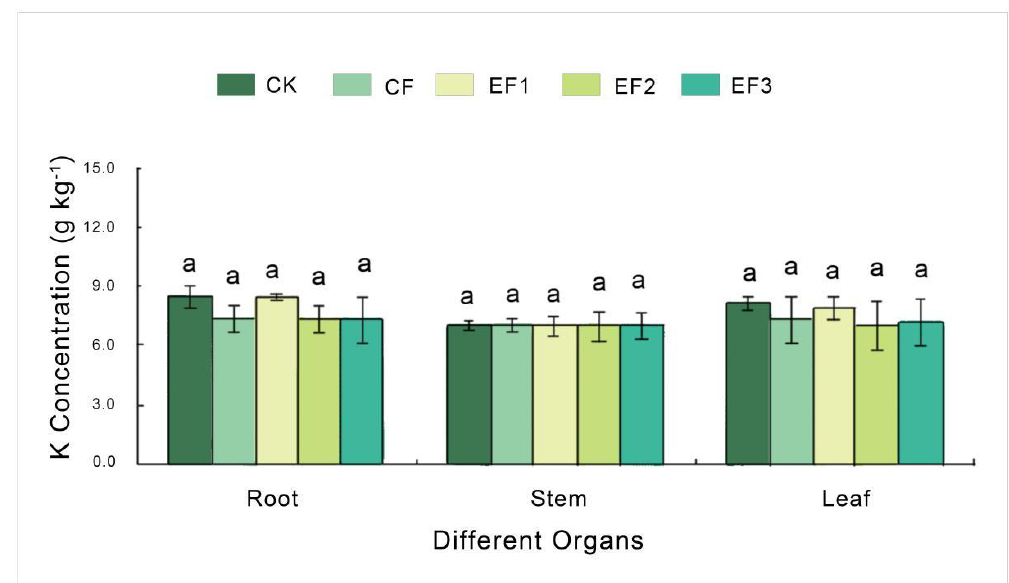
Figure 6. Organ potassium (K)-concentration of Chinese fir at different fertilization levels. (Different letters in the same histogram of organs indicate significant difference at 0.05 level).